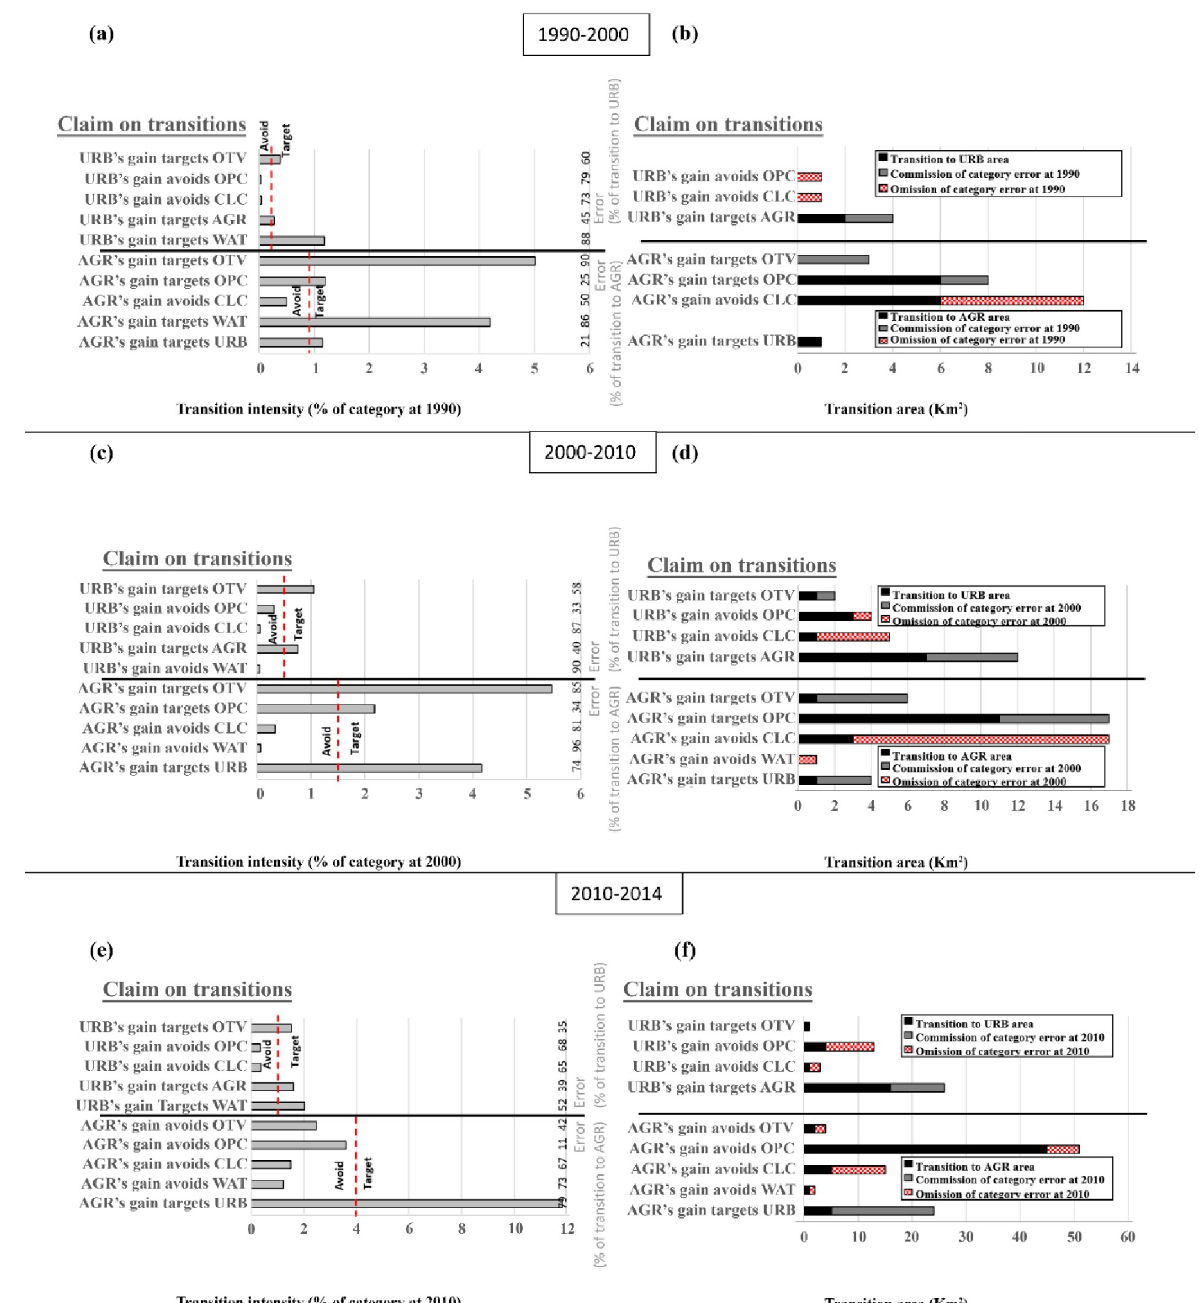
Fig 5. Transition level analysis for URB gain and AGR gain during the three time intervals. Graphs on right show transition intensity and graphs on left show sizes of transitions along with hypothetical errors at the initial time point map that could account for deviations from uniform transition intensities indicated by the dashed uniform